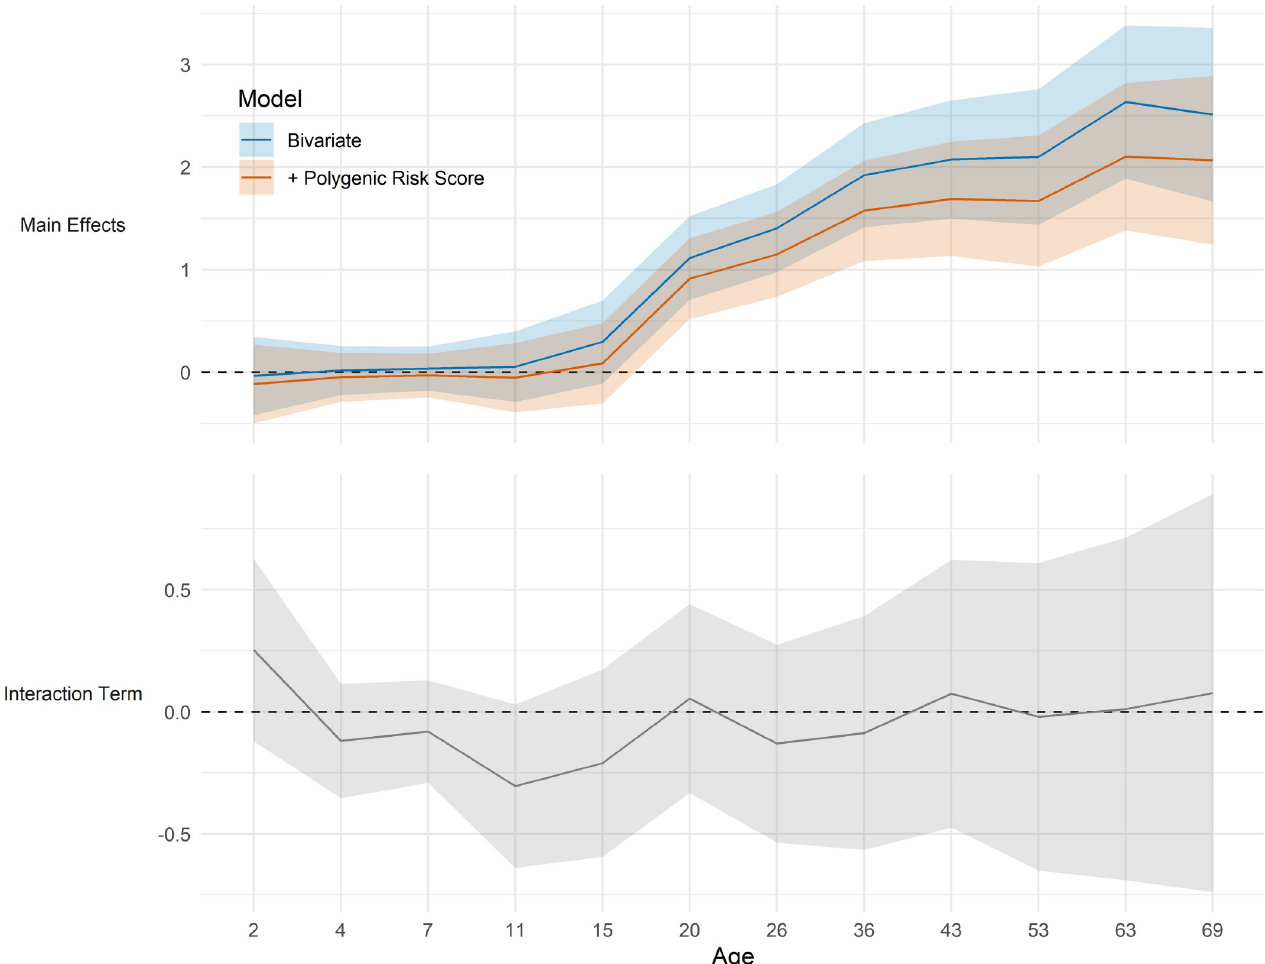
Fig 4. Childhood socioeconomic position and polygenic index in relation to body mass index (BMI) across life. Top panel shows the kg/m 2 difference in BMI in the lowest compared with highest socioeconomic position, before and after adjustment for Khera et al. (2019)[4] polygenic index for higher BMI. Bottom panel shows coefficients for the social class x polygenic index interaction term (null line is evidence for no interaction). SEP measured as father’s occupational class converted to ridit score. Results from top panel drawn from OLS regression models including adjustment for sex (blue solid line) and further adjustment for polygenic indices and first ten genetic principal components (orange line). Results from bottom panel drawn from OLS regression models including adjusted for sex, polygenic index [4], first ten genetic principal components and SEP.